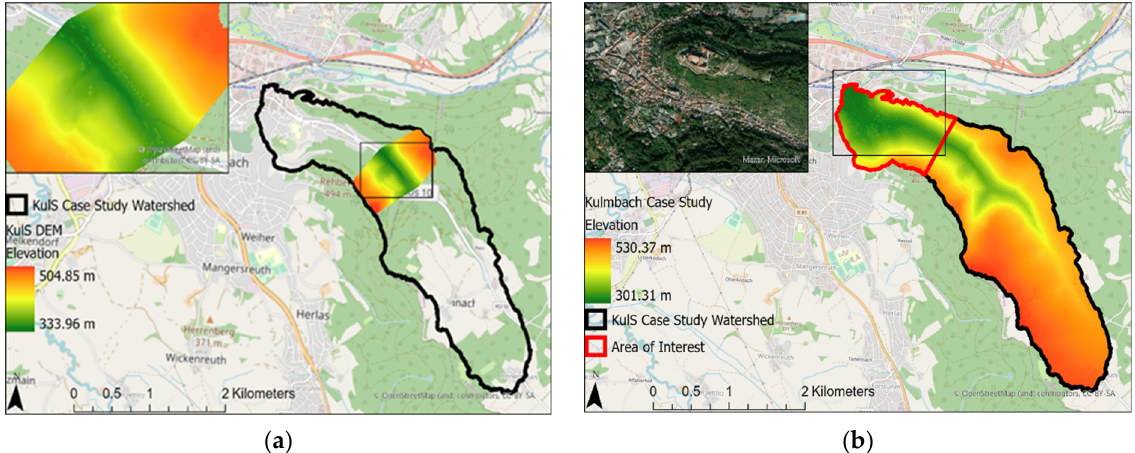
Figure 2. Catchment area and topography of the study area. ( a ) Pre-validation area for the first stage of the validation procedure; ( b ) final validation area for the second stage of the validation procedure.